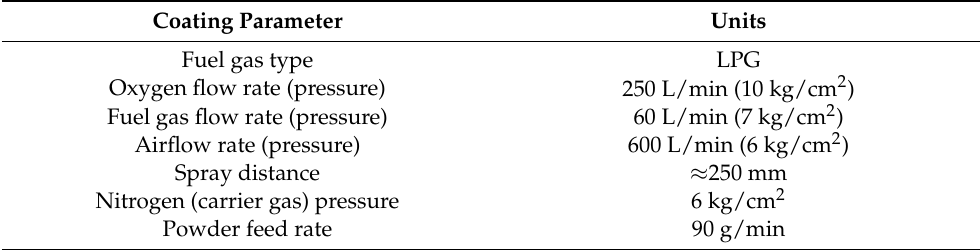
Table 2. HVOF spray coating parameters.